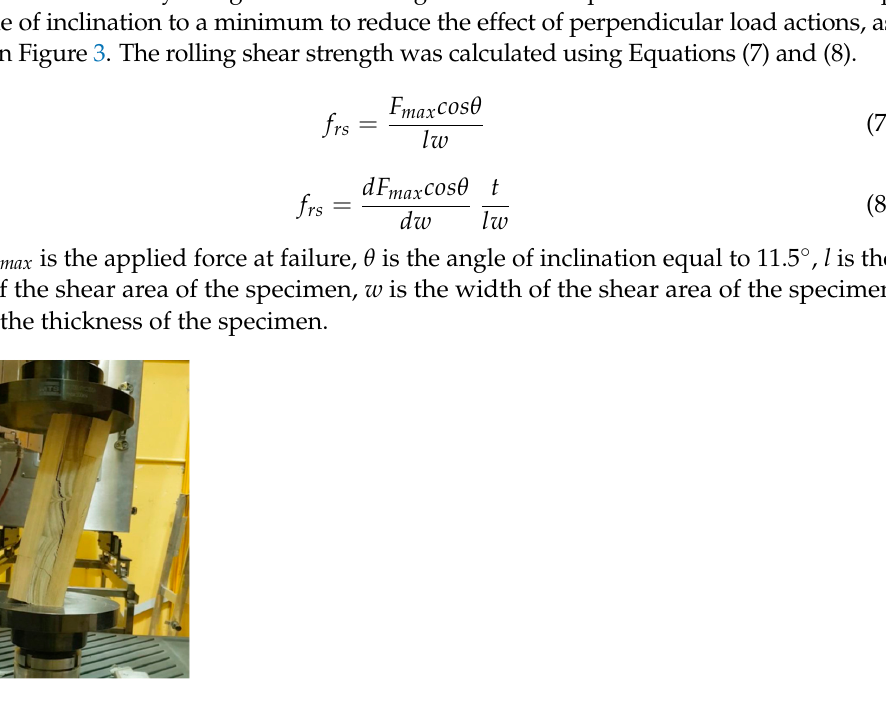
Figure 3. Rolling shear strength and stiffness derived from pure rolling shear tests on E. nitens CLT panels.